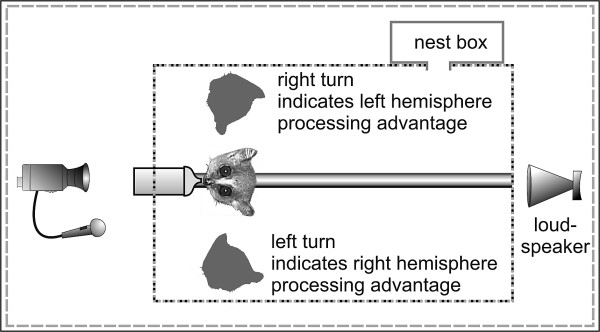
Experimental setup.